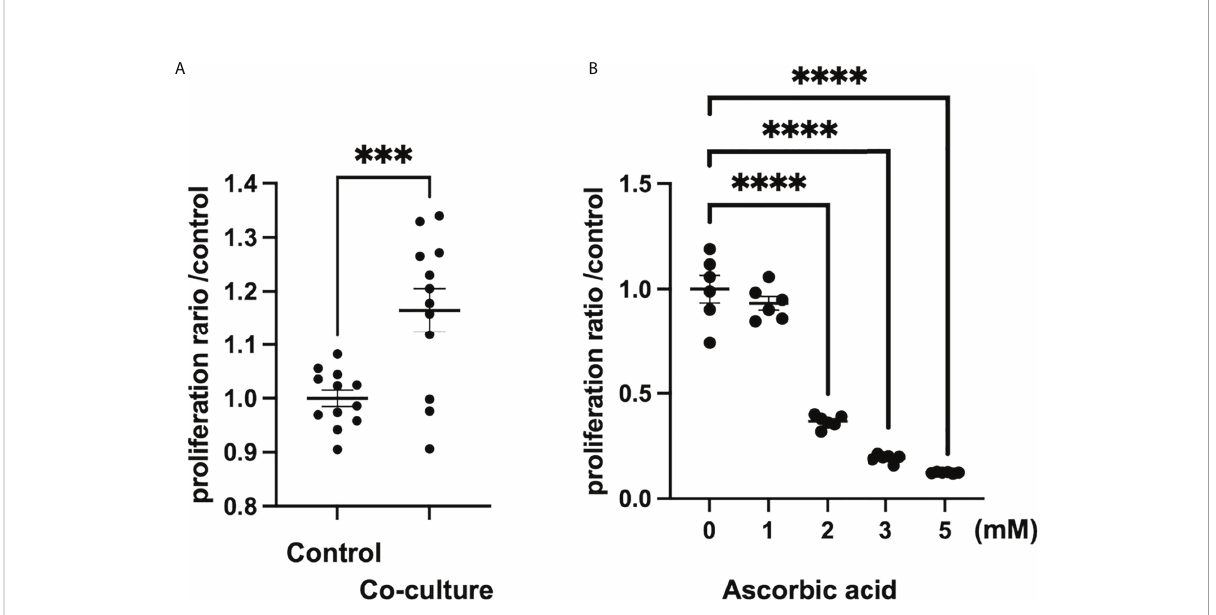
FIGURE 1 Ascorbic acid reduces the proliferation of human-derived pancreatic fi broblasts (hPFs). (A) Proliferation of hPFs is increased in a co-culture with a pancreatic cancer cell line (MIAPaCa2). ***P < 0.001 versus control, means ± SEM, n = 12. (B) Proliferation of hPFs is dose-dependently reduced by high-dose ascorbic acid treatment. ****P < 0.0001 versus ascorbic acid 0 mM, means ± SEM, n = 6. Statistical analysis was performed by GraphPad Prism 9 and signi fi cance was determined by Student ’ s